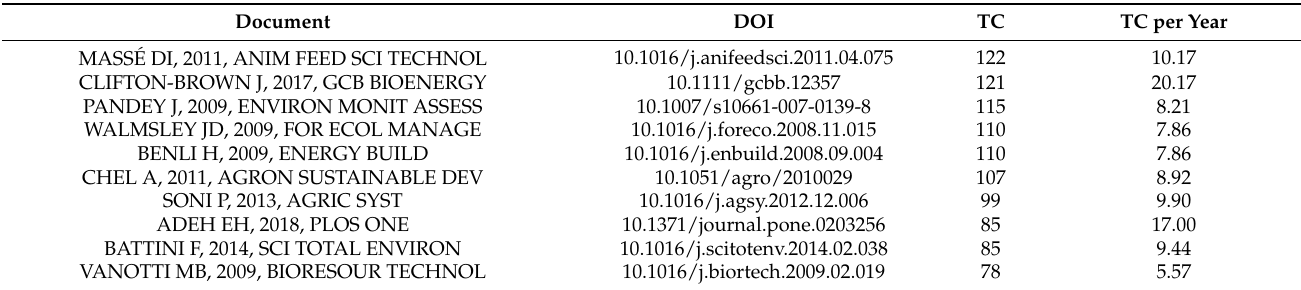
Table 5. List of the most cited articles on the